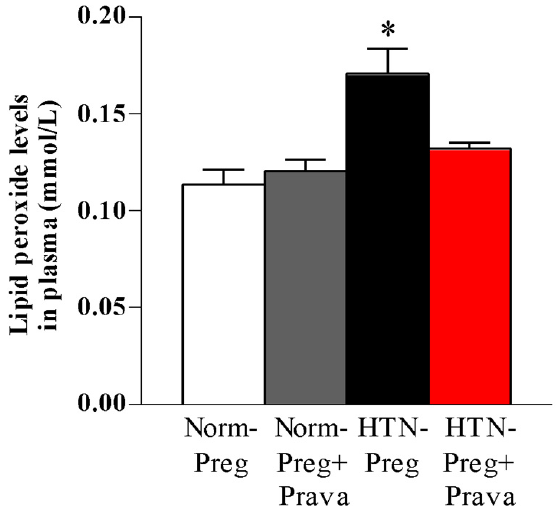
Figure 5. Lipid peroxide levels in plasma determined in Norm-Preg, Norm-Preg + Prava, HTN-Preg, and HTN-Preg + Prava groups. Values represent mean ± SEM. * p < 0.05 vs. Norm-Preg group. Antioxidant capacity of plasma was significantly reduced in the HTN-Preg group compared to the Norm-Preg, Norm-Preg + Prava, and HTN-Preg + Prava groups (Figure 6 and Supplementary Table S1), demonstrating that pravastatin prevented the impairment in the plasma antioxidant capacity that induced hypertensive pregnancy.